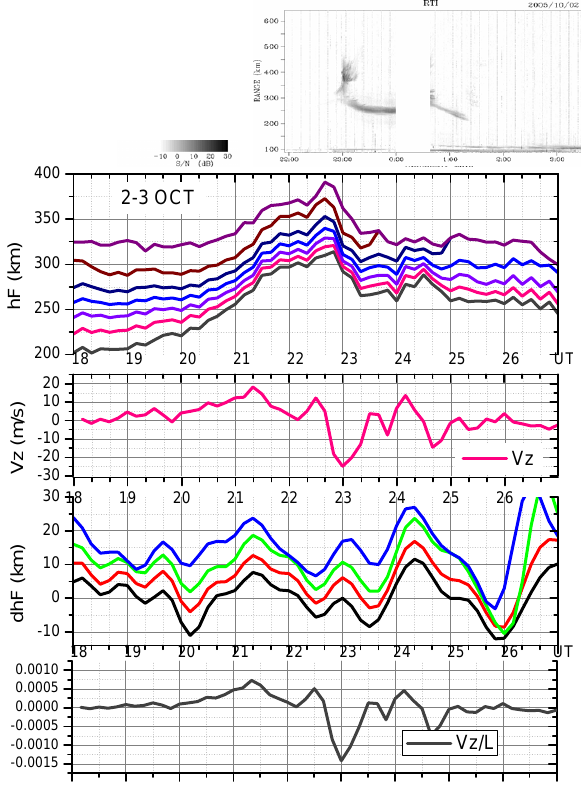
Fig. 3a. Plots similar to those of Fig. 2a and b, but for the evening- night period of 2–3 October 2005. Fig. 3b. Plots similar to those of Fig. 2a and b, but for the evening- night period of 5–6 October